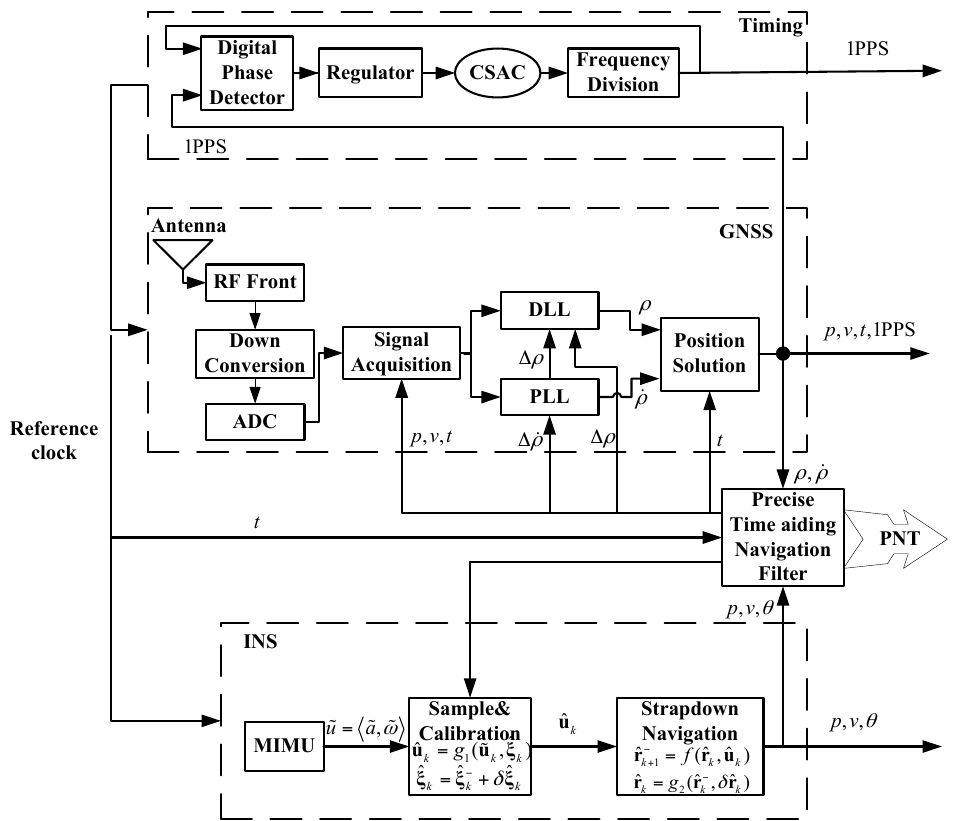
Figure 1. Architecture of chip scale atomic clock (CSAC), MEMS inertial measurement unit (MIMU), and global navigation satellite systems (GNSS) coupled integration. MEMS refers to micro-electromechanical systems.